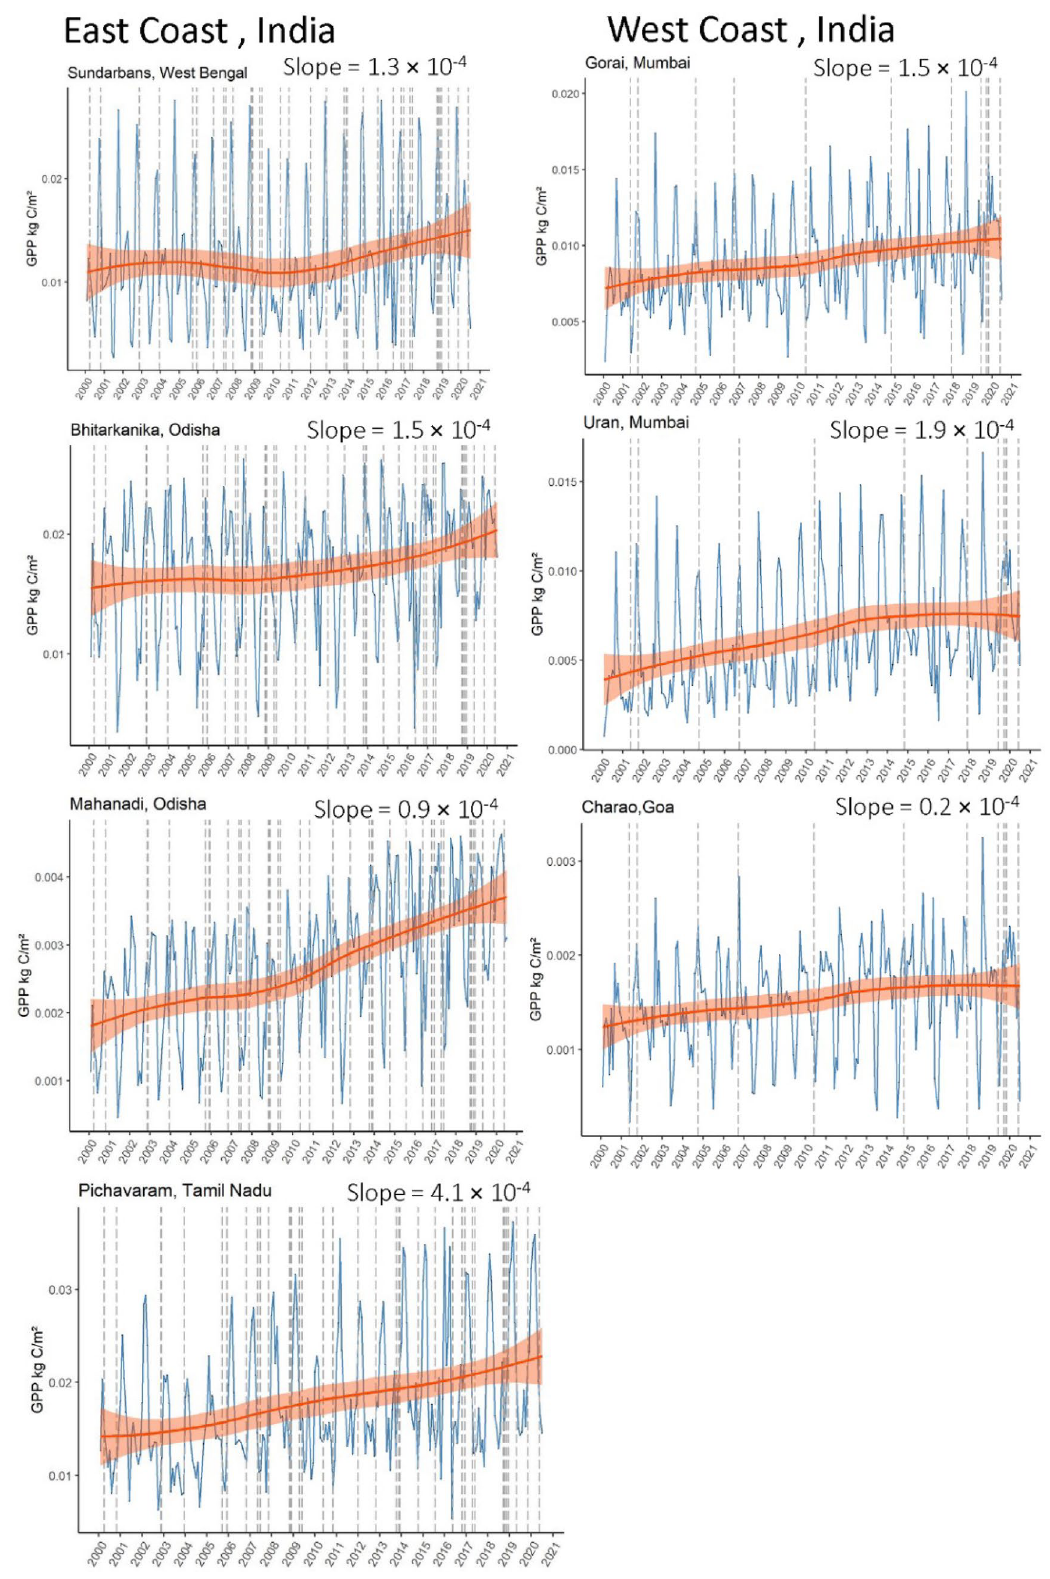
Figure 2. Time series of GPP for seven mangrove sites from Jan 2000 to July 2020. Dotted vertical lines indicate cyclone activity along the coast (number of tropical cyclones on the East coast, n = 39 and West coast, n = 12). Blue lines indicate the seasonal trend of GPP in a given